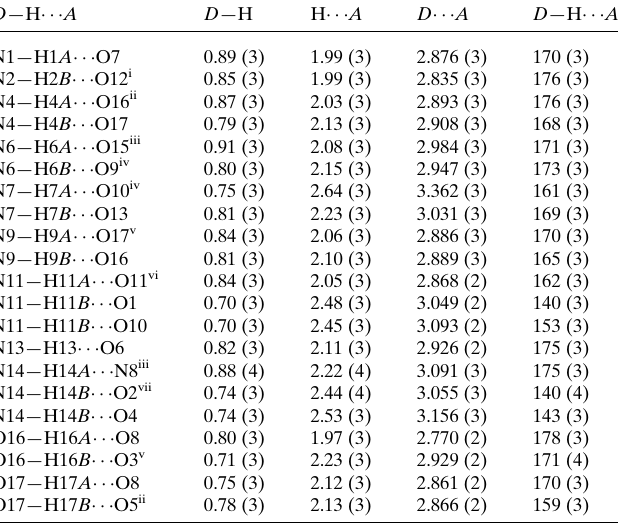
Table 1 Hydrogen-bond geometry (A˚ , (cid:4) ).